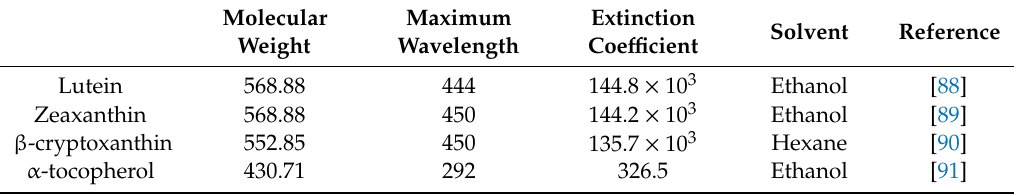
Table A3. Calibration standards used to quantify xanthophyll carotenoids and vitamin E. Molecular Maximum Extinction Weight Wavelength Coe ffi cient